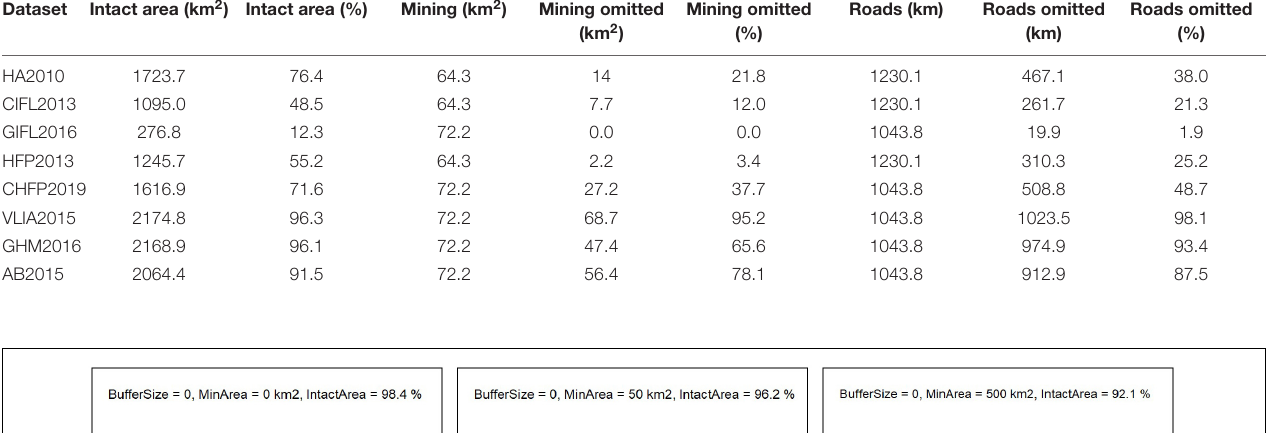
TABLE 6 | Percentage of polygonal (placer mining) and linear (mostly roads) disturbances omitted (misclassified as intact) in the Indian River watershed, Yukon (2,257.4 km 2 ). Dataset Intact area (km 2 ) Intact area (%) Mining (km 2 ) Mining omitted